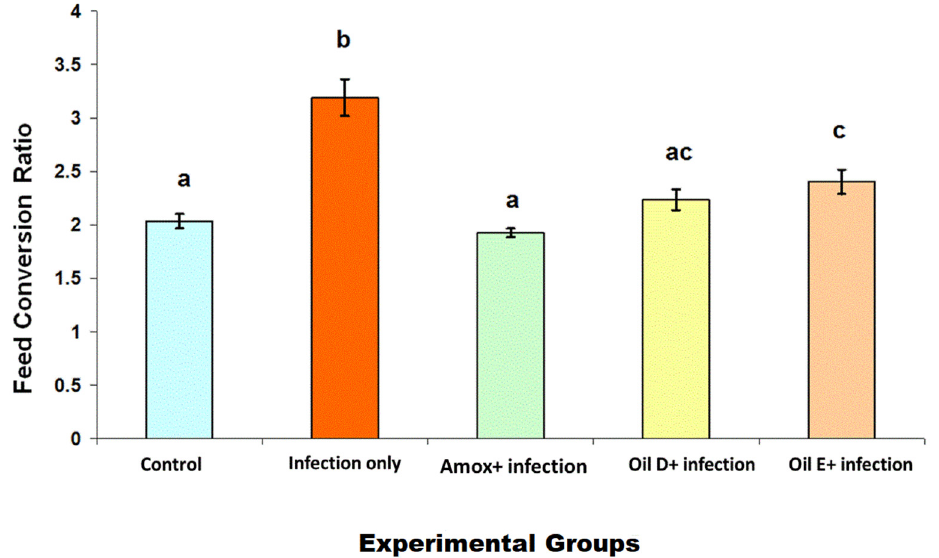
Figure 1. Feed conversion ratio in birds in response to NE caused by C. perfringens infection. The feed conversion ratio was calculated by dividing the average feed intake over the average weight gain per replicate per group. The values are means ± S.E. Different letters represent statistically significant differences with a p -value less than 0.05.